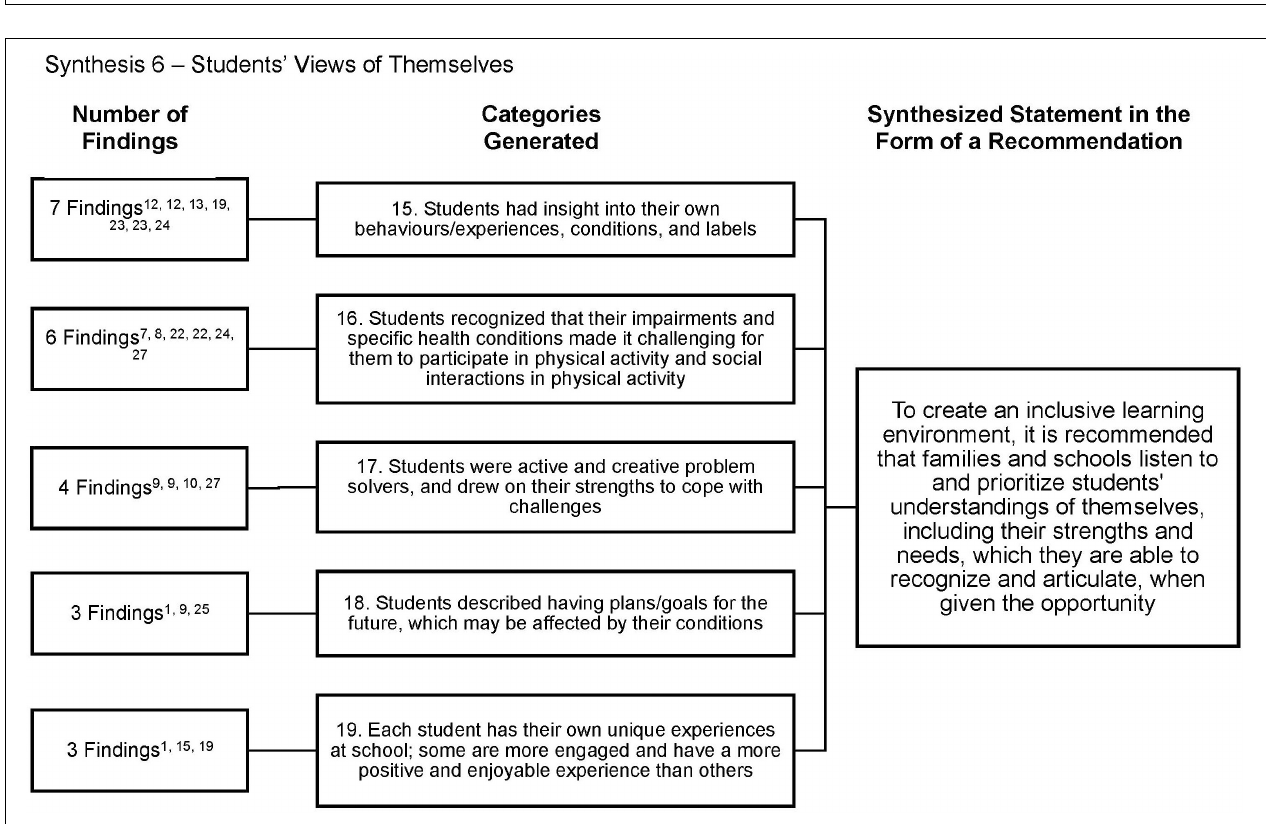
FIGURE 7 | Synthesis 6 – students’ views of themselves. The superscript numbers under “Number of Findings” corresponds to the study numbers in Table 3 .